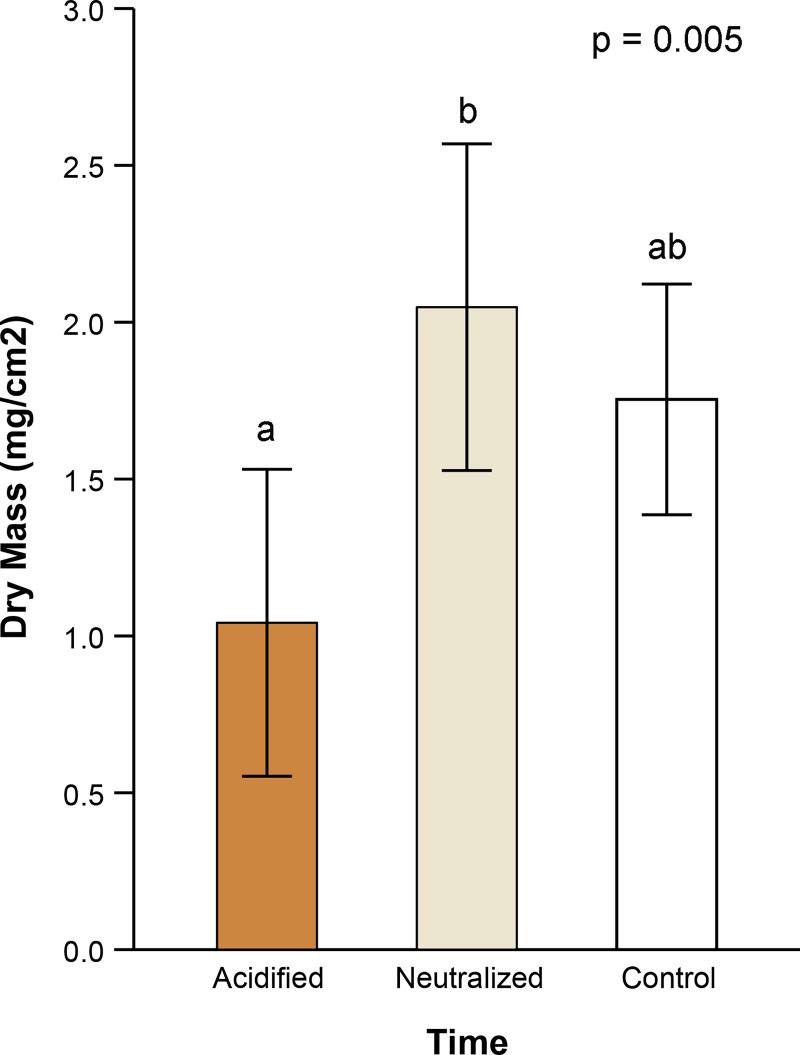
Effects of acid treatment on algal dry mass.The average algal dry mass for floways treated with hydrochloric acid, neutralized hydrochloric acid, or nothing (i.e., control). Error bars represent 95% confidence intervals. Bars not sharing the same letter differ statistically in pairwise, post hoc comparisons (Bonf, p < 0.05 for all significant comparisons). Probability indicates the p-value associated with the overall treatment effect (i.e., acidification regime) from the repeated measures statistic.